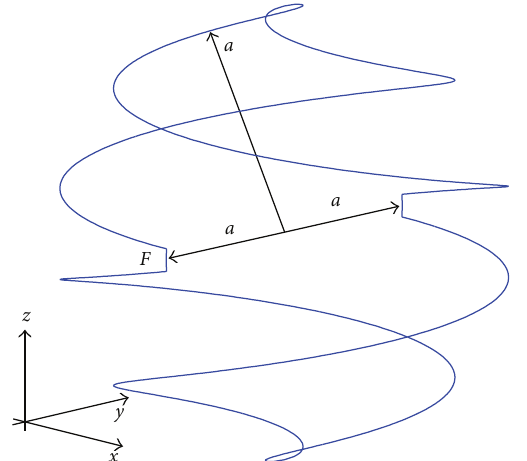
Figure 6: Extinction, absorption, and scattering cross sections of the spherical helix depicted in Figure